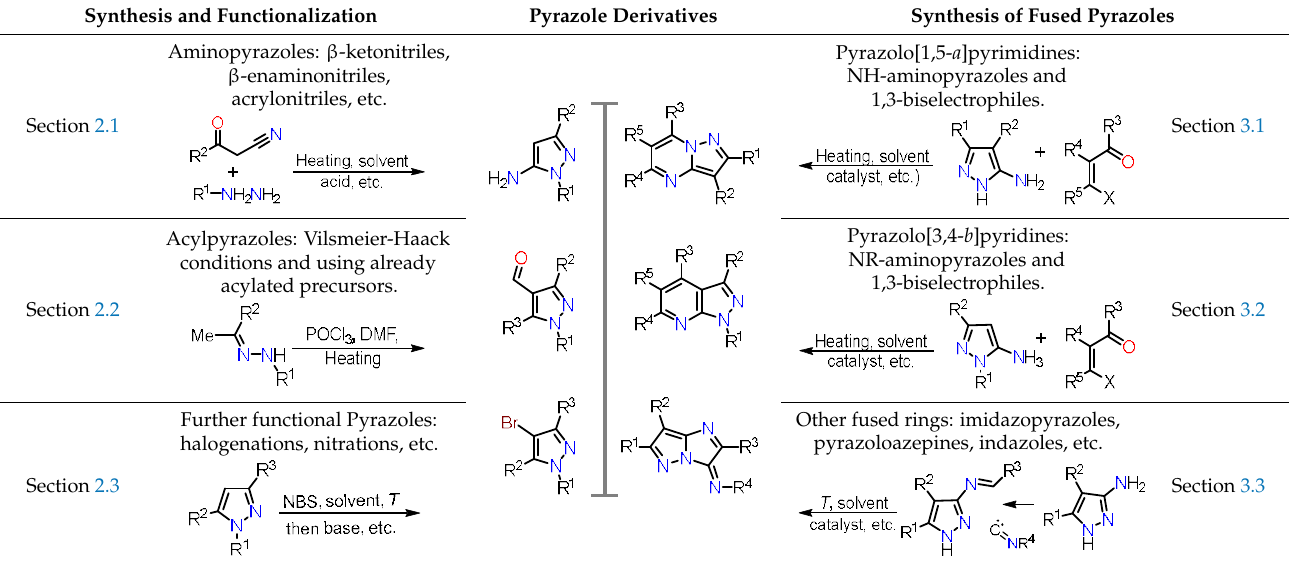
Figure 3. Physically relevant molecules based on ( a ) pyrazoles and ( b ) their fused systems.